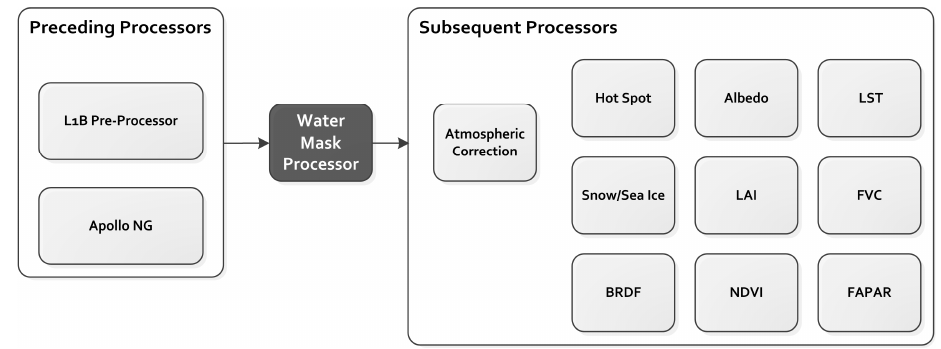
Figure 1. Overview of the processing chain of the TIMELINE project with the position of the water mask processor highlighted in dark grey. Apollo NG: Next Generation Apollo [1] (cloud processing scheme), BRDF: Bidirectional Reflectance Distribution Function, LST: Land Surface Temperature, NDVI: Normalized Difference Vegetation Index, LAI: Leaf Area Index, FVC: Fractional Vegetation Cover, FAPAR: Fraction of Absorbed Photosynthetically Active Radiation.